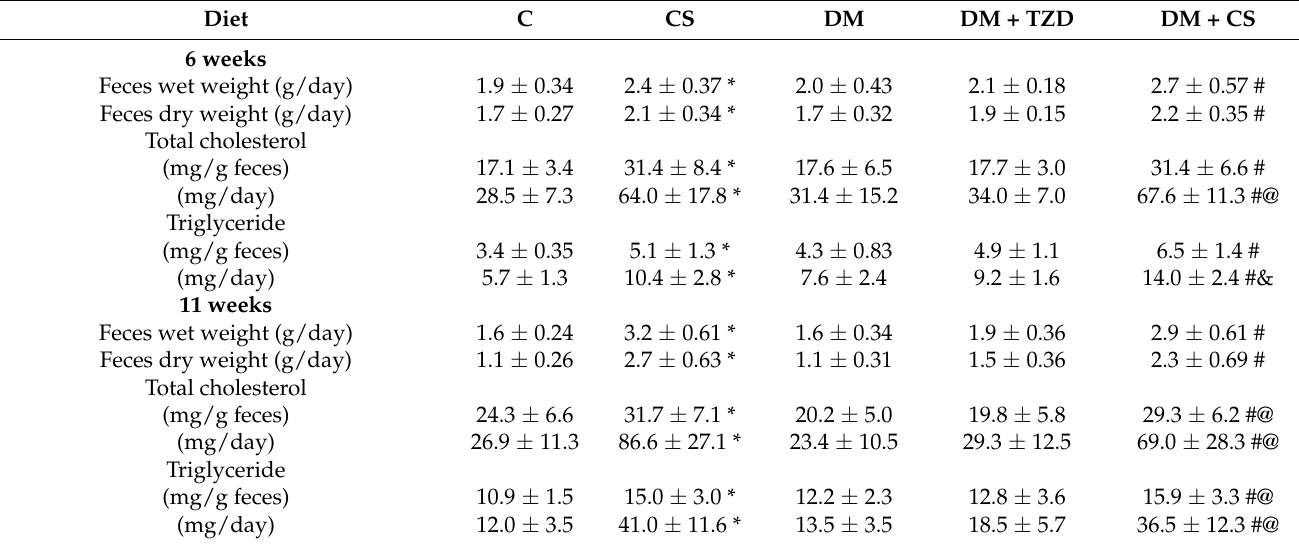
Table 6. The changes of fecal weight, total cholesterol, and triglyceride levels in SD rats fed different experimental diets for 6 and 11